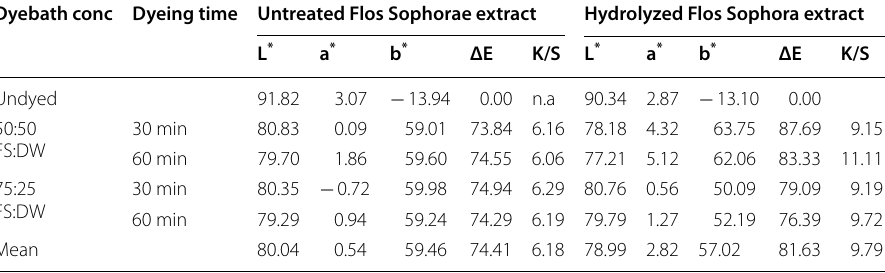
Dyebath conc Dyeing time Untreated Flos Sophorae extract Hydrolyzed Flos Sophora